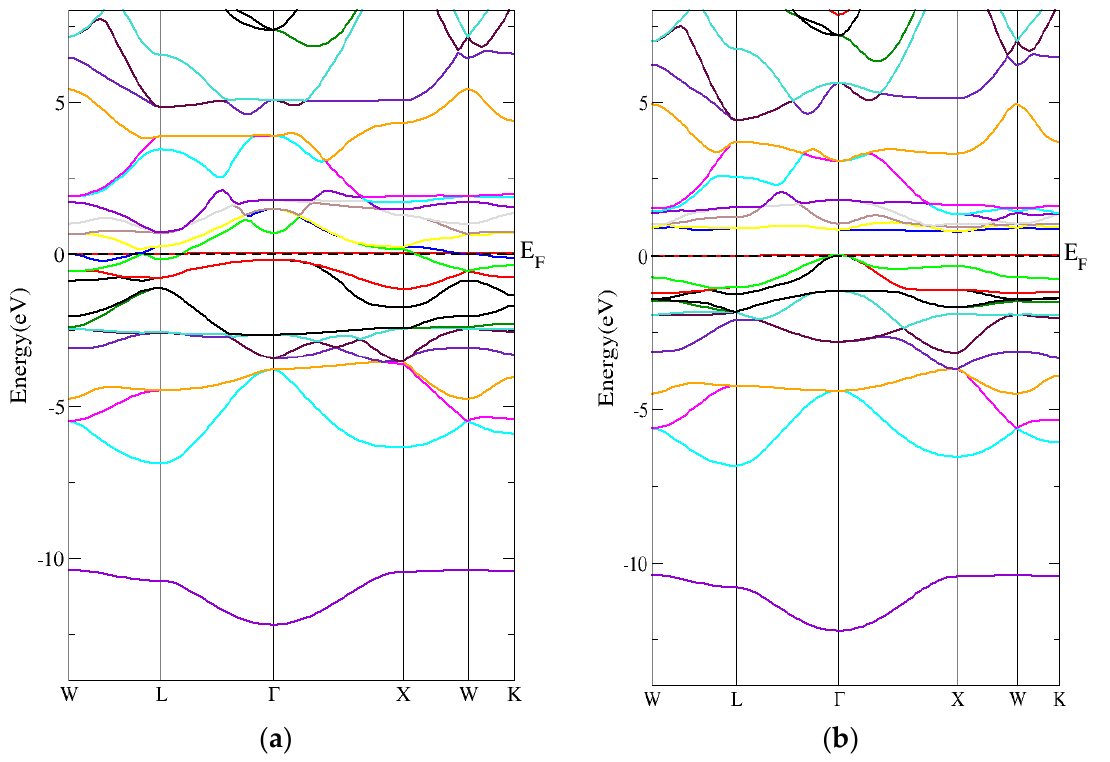
Figure 10. The band structure for the conventional Heusler Cr 2 MnSb compound by employing the PBE–GGA technique for ( a ) spin-up conventional Heusler Cr 2 MnSb compound and ( b ) spin-down conventional Heusler Cr (cid:2870) MnSb compound.